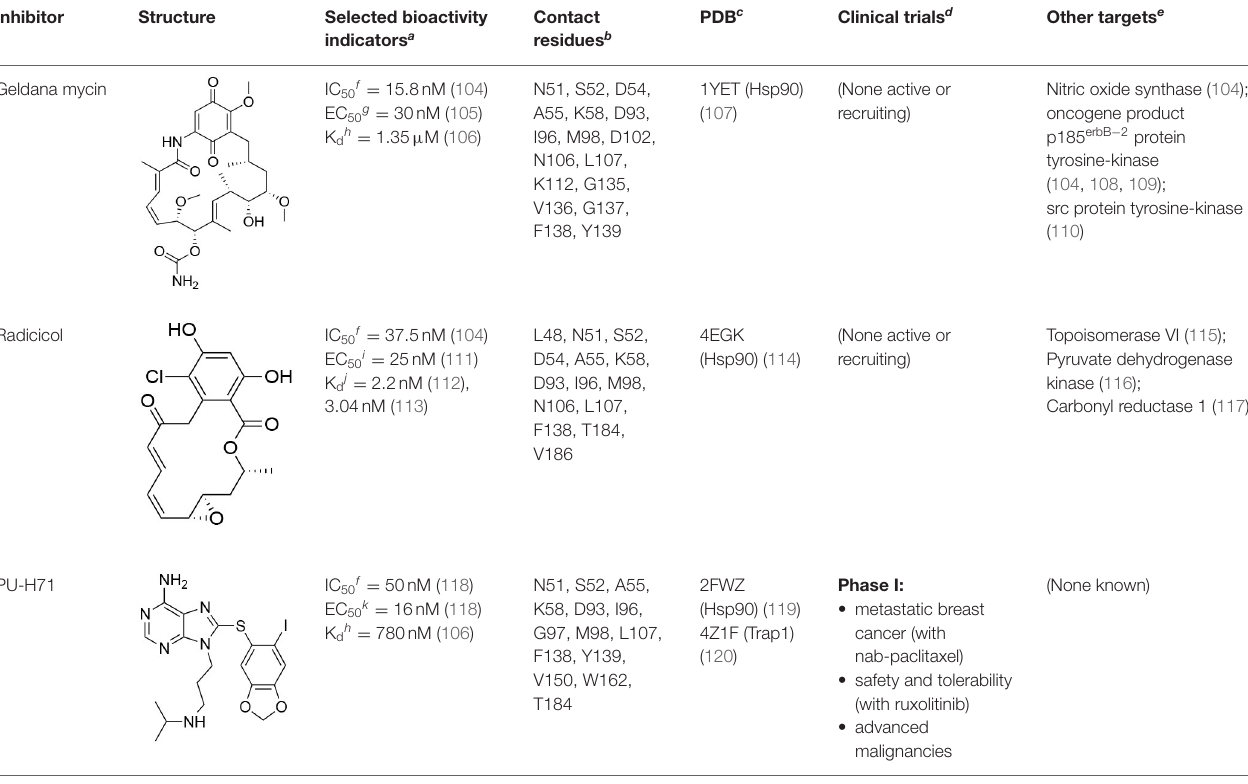
TABLE 3 | Key data concerning orthosteric Hsp90 inhibitors Geldanamycin, Radicicol, and PU-H71.